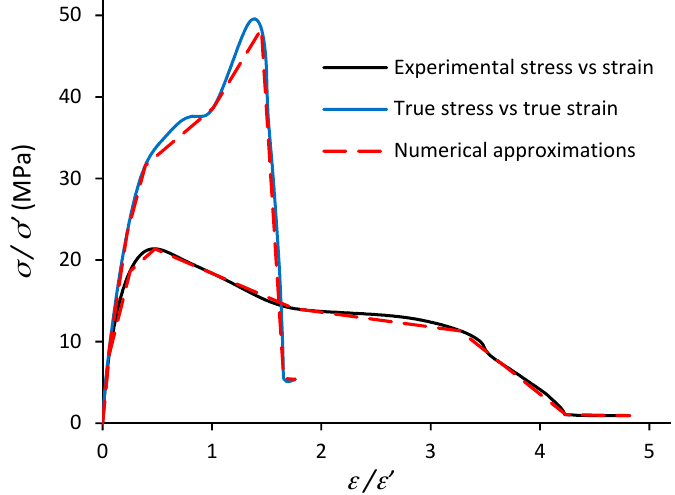
Figure 5. Stress-strain curves for the MDPE adherend and numerical approximation for the FEM analysis.